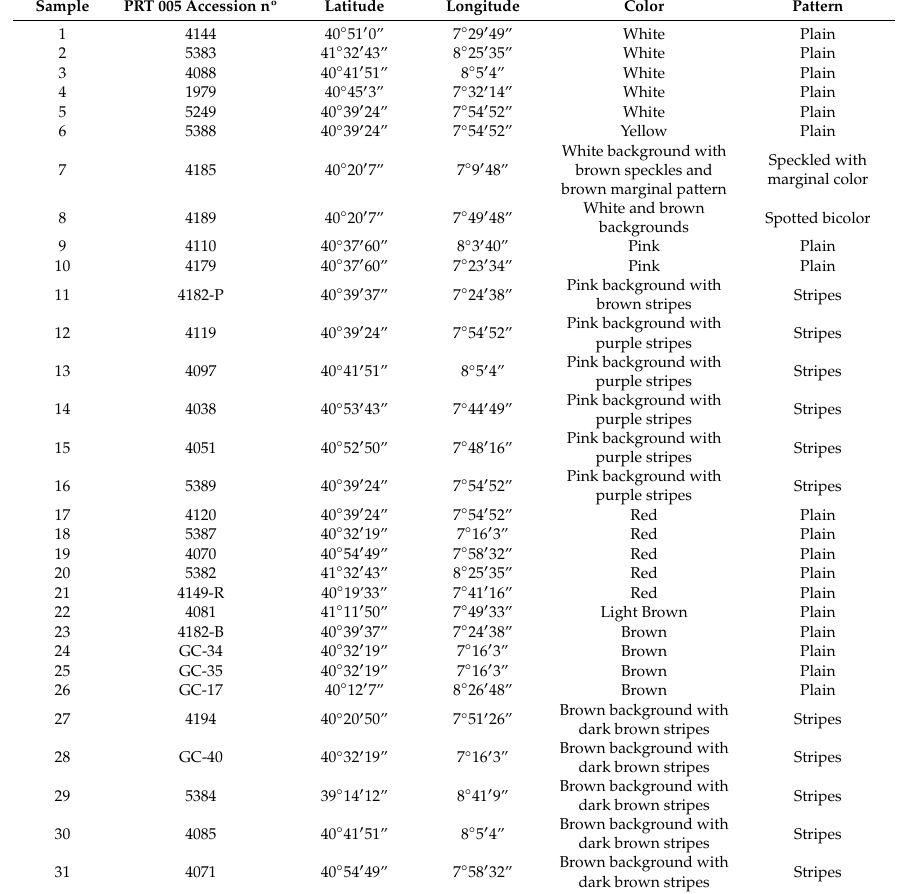
Table 1. Accession numbers (PRT 005 germplasm bank collection) of Portuguese common bean’s varieties, corresponding locations (latitude and longitude), seed color and